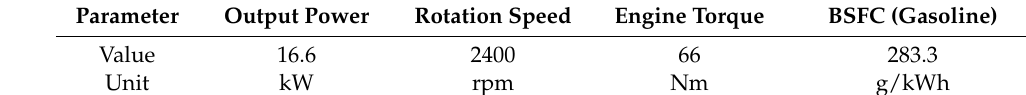
Table 7. Parameters of REX operating point selected for simulation.